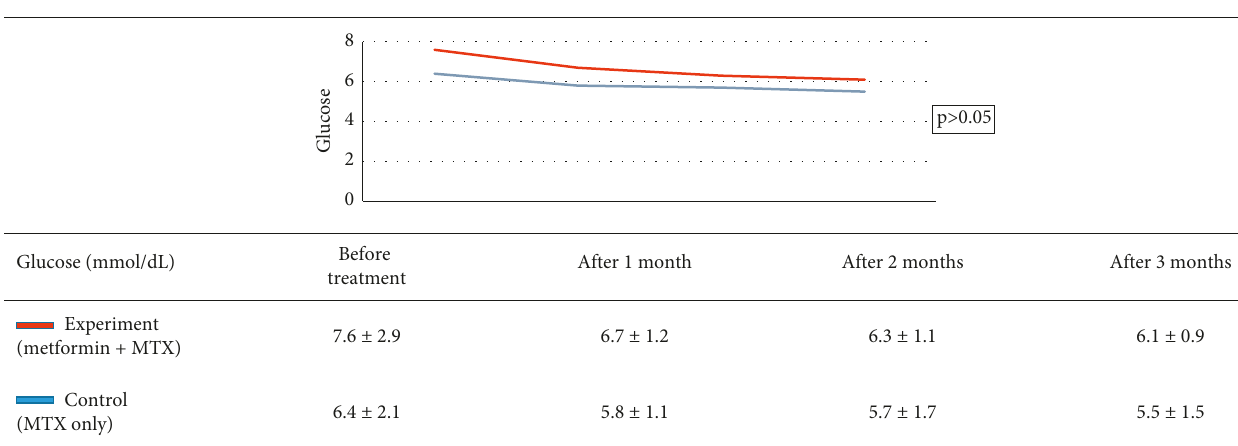
Table 7: Comparison of treatment results of two groups according to the venous blood glucose